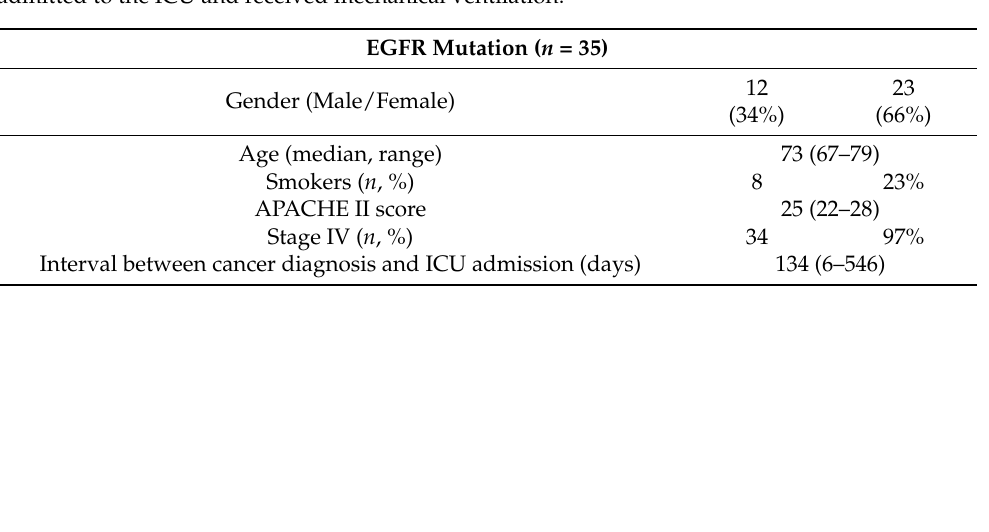
Table 1. Demographic data and treatment outcome of EGFR-TKI-treated NSCLC patients who were admitted to the ICU and received mechanical